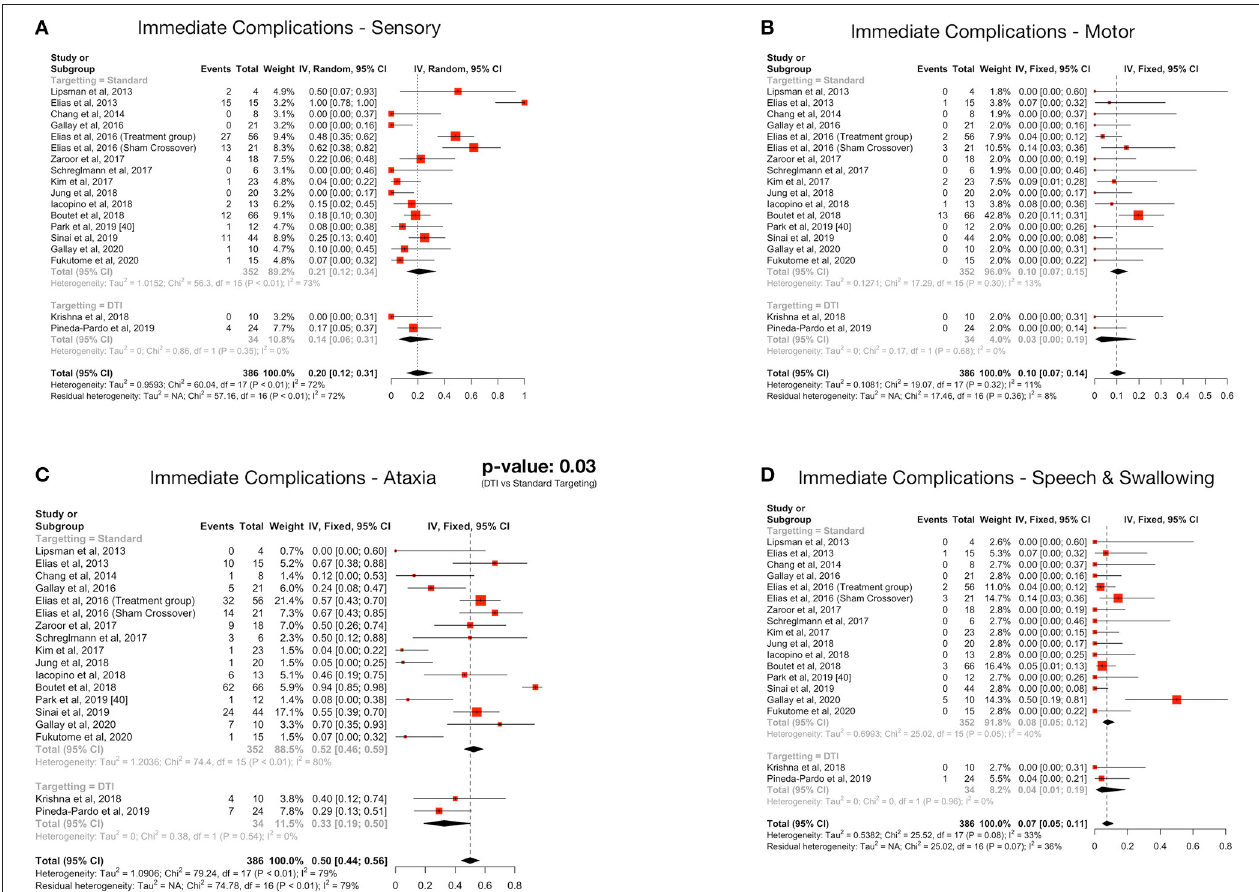
FIGURE 4 | Forest plots depicting pooled proportions of immediate sensory (A) , motor (B) , ataxia (C) and speech and swallowing (D) related